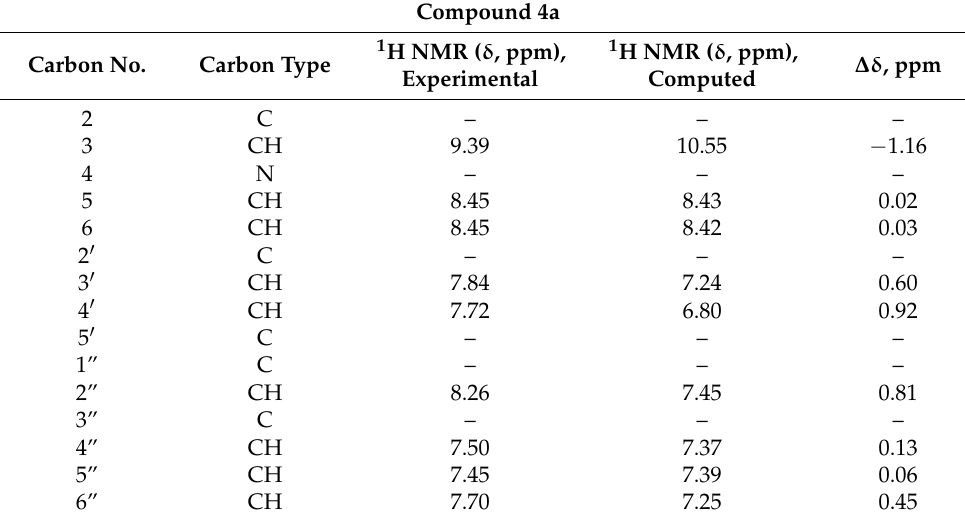
Table 1. Comparison of the experimental and theoretical 1 H NMR data of compound 4a . The data for the rest of the compounds is provided in the Supplementary Materials. The mean absolute deviation is presented as the mean absolute error and, similarly, the root-mean-square deviation is denoted as the root-mean-square